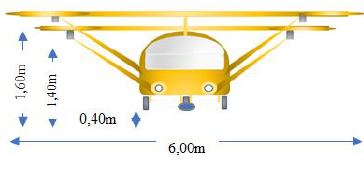
Figure 7 . Basic model Front view and dimensions.